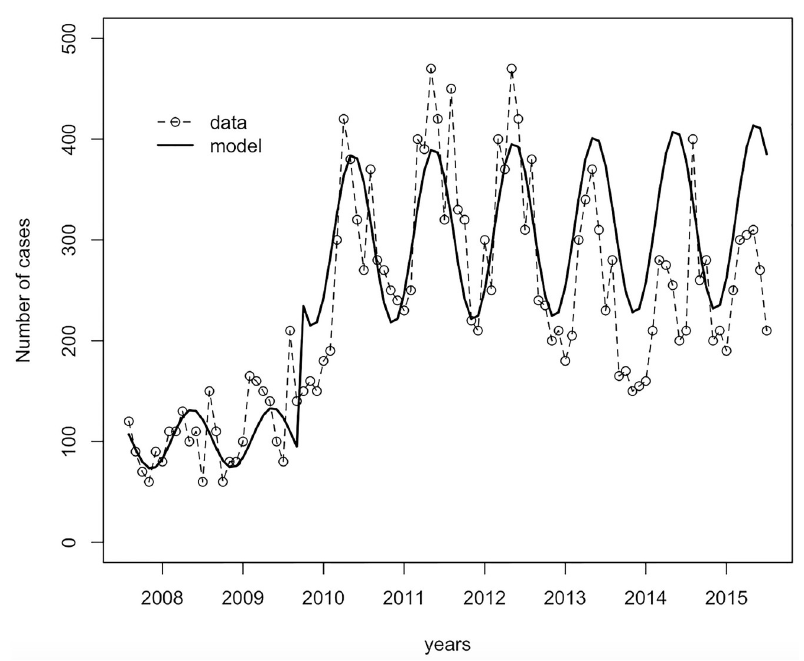
Fig 2. Comparing the observed and model estimates of monthly melioidosis cases between 2005 and